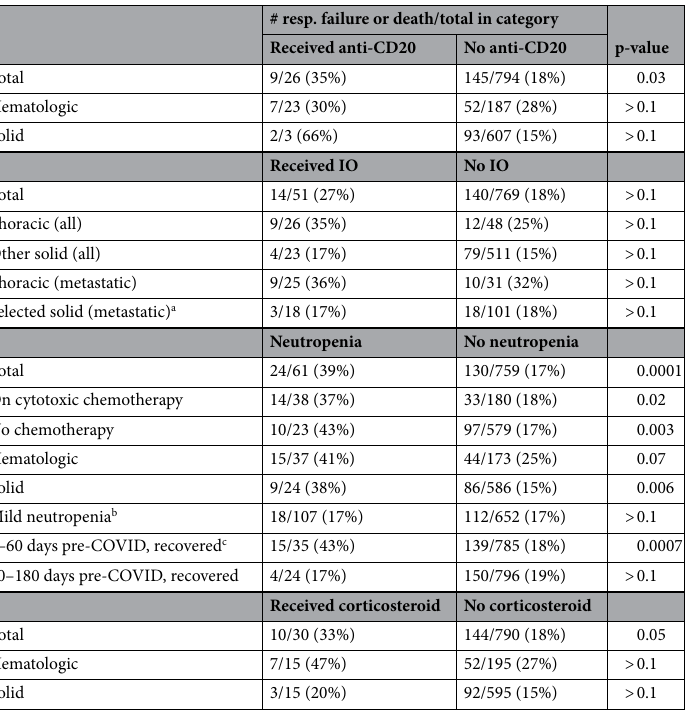
Table 2. Rate respiratory failure or death among patients treated and not treated with anti-CD20 agents and immunotherapy (IO) and with or without neutropenia pre-COVID-19. a Limited to patients with solid metastatic cancer deemed eligible for immunotherapy by cancer type (N = 179), specifically triple negative breast cancer, colorectal cancer, renal cancer, bladder cancer, melanoma, cervical or uterine cancer, esophageal or stomach cancer, or hepatocellular carcinoma. b Mild neutropenia: at least one measured ANC < 2 K/µL and all measured ANC > 1 K/µL within 7 to 60 days prior to SARS-CoV-2 diagnosis. c Recovered neutropenia: at least one measured ANC < 1 K/µL during the stated time window and subsequently at least one ANC ≥ 1 K/µL and no measurements of ANC < 1 K/µL after SARS-CoV-2